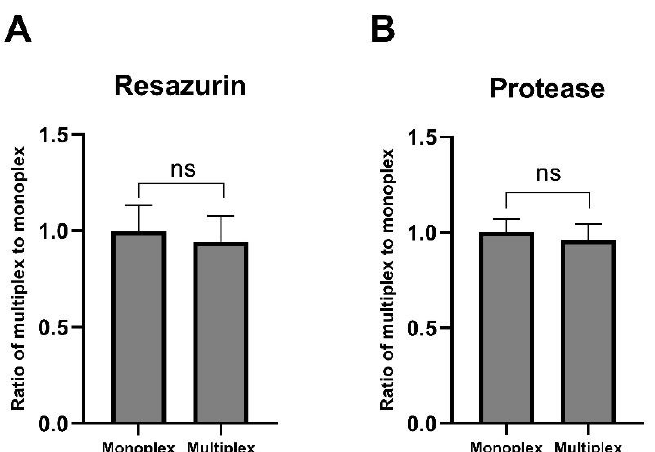
Figure 3. Multiplexing resazurin and protease assays in D341 cells. For the monoplex assay, agar plates were incubated with resazurin substrate (6 h) or GF-AFC substrate (3 h) alone. For the multiplex assay, plates were incubated with resazurin substrate for 3 h followed by GF-AFC substrate in the same well for another 3 h. Plates were analysed for ( A ) resorufin signal at 560/590 nm excitation/emission and ( B ) GF-AFC signal at excitation/emission wavelength of 380/505 nm. Data expressed as mean ± standard deviation from three independent experiments with four replicates each. ns = not significant ( p > 0.05), t -test with two-tailed comparison.